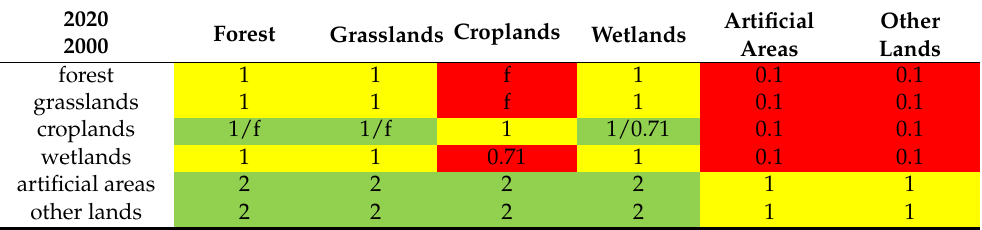
Table 1. Land use conversion coefficients for evaluating SOC.